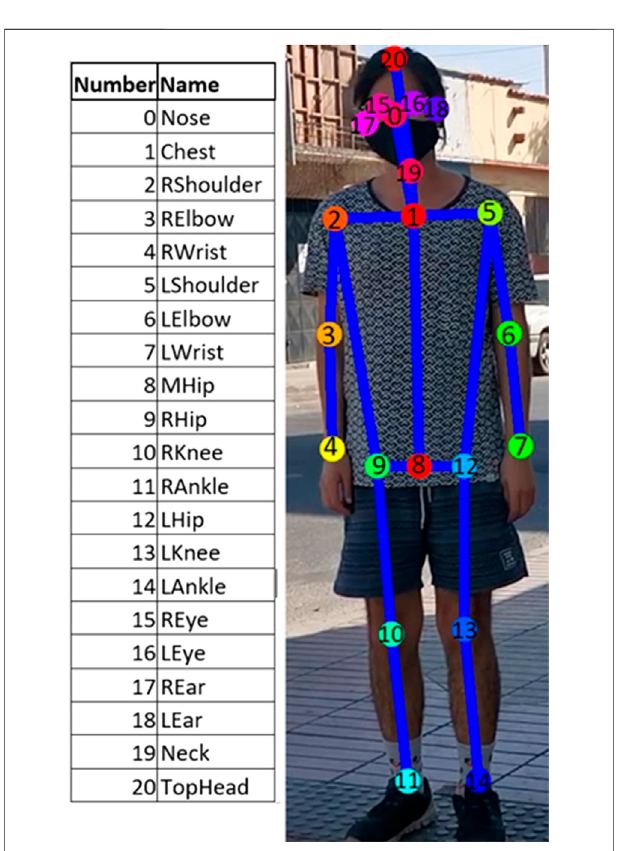
FIGURE 2 | Key-points detected by OpenPose and their numeric code.